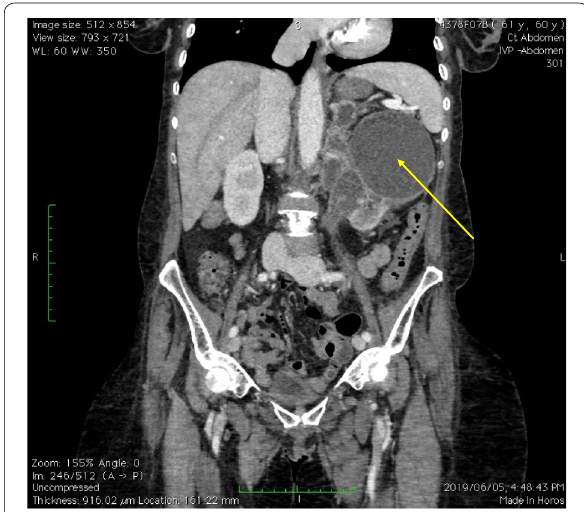
Fig. 1 Contrast-enhanced CT scan of the abdomen showing a heterogeneous soft tissue density mass involving the renal pelvis and ureter (arrow)